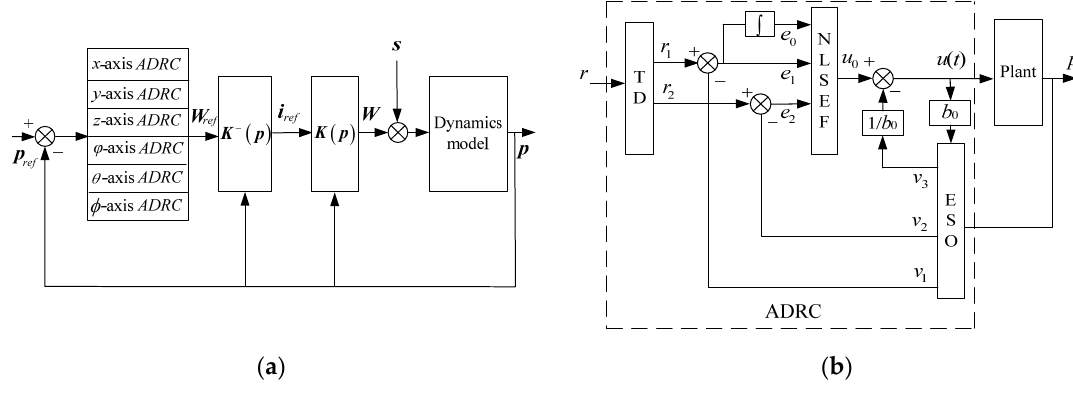
Figure 3. Control system diagram: ( a ) control system structure of the maglev planar motor; and ( b ) configuration of a second ‐ order ADRC.